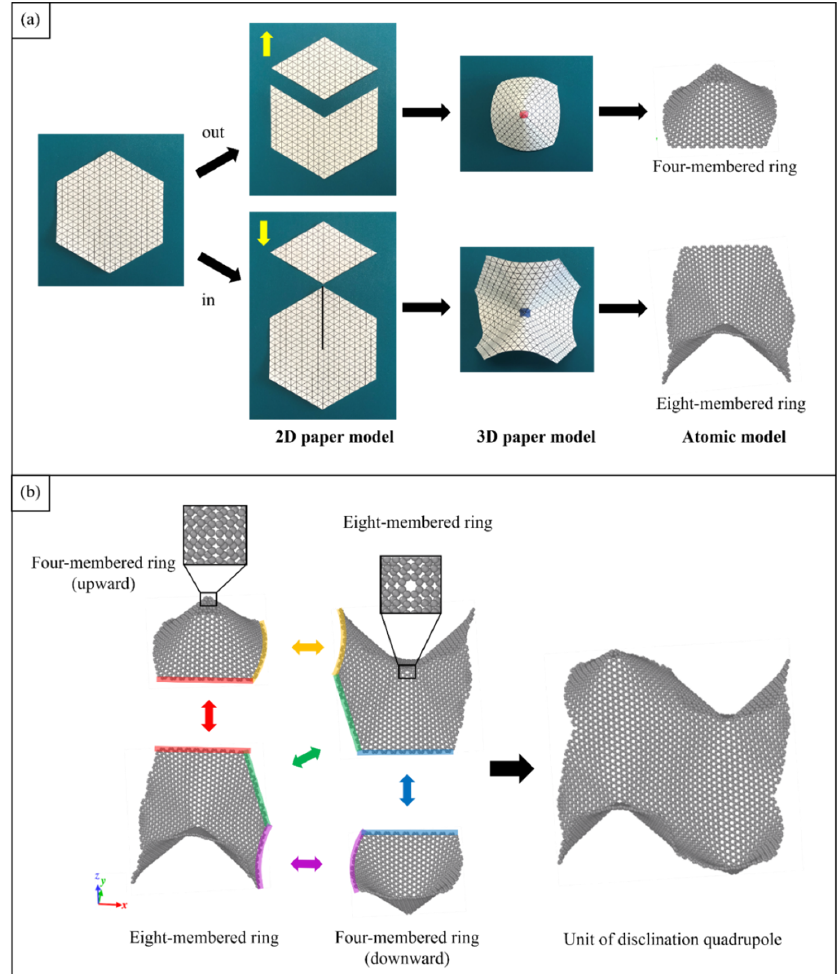
Figure 1. ( a ) Generation of disclination models; ( b ) Atomic model of the disclination quadrupole unit composed of isolated disclinations of two pairs of four- and eight-membered rings.